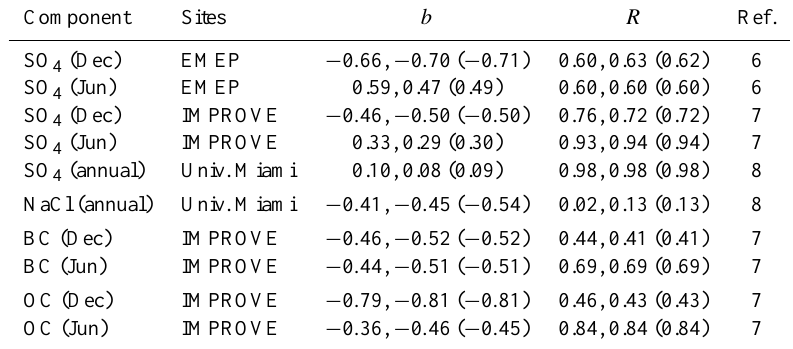
Table 4. Simulated aerosol mass of sulphate, sea-salt, BC and OC against surface observations for bin and mode, respectively (comma- separated). for each of the benchmark observational datasets, Normalised mean bias ( b ) and Pearson correlation coefficient ( R ) are shown. The GLOMAP-mode run with the original accumulation mode standard-deviation and mode-edge radius is shown in parentheses. References for the observations are 6: Loevblad et al. (2004) 7: Malm et al. (2002) 8: from Stier et al.